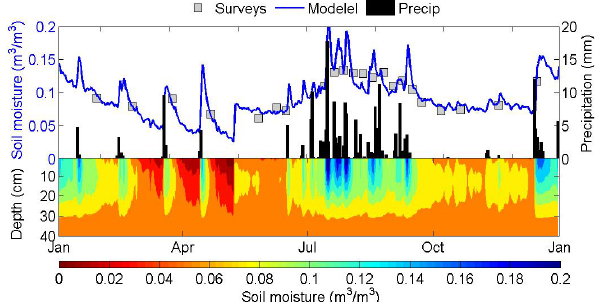
Fig. 9. Top: time-interpolated soil moisture (blue line) generated from the modeled results where the mean soil moisture was esti- mated from the Santa Rita COSMOS point measurement. Precipi- tation amounts are shown as black bars and rover surveys as gray boxes. Bottom: soil moisture profiles generated from three depth points. The abrupt shift in the mean soil moisture is due to the change in the linear regression relationship from winter to summer and is an artifact in the